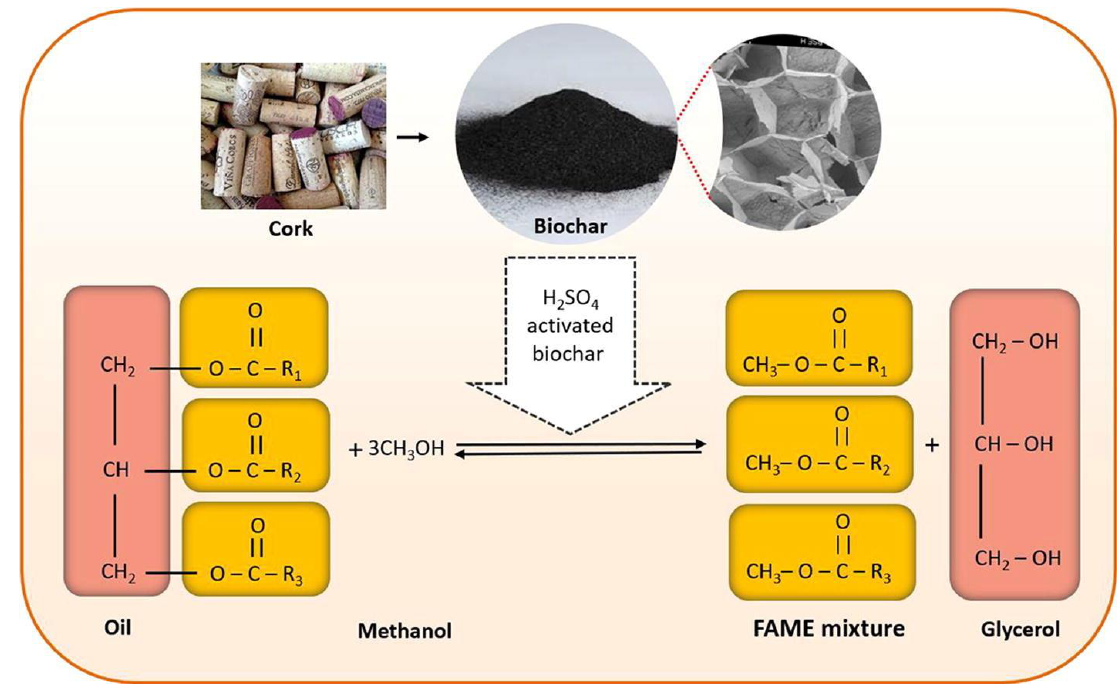
Figure 5. Pictorial representation of transesterification of waste cooking oil by using a heterogene- ous catalyst prepared by pyrolysis of waste cork (Quercus suber). Reprinted with permission from Ref. [61]. 2022, Elsevier.